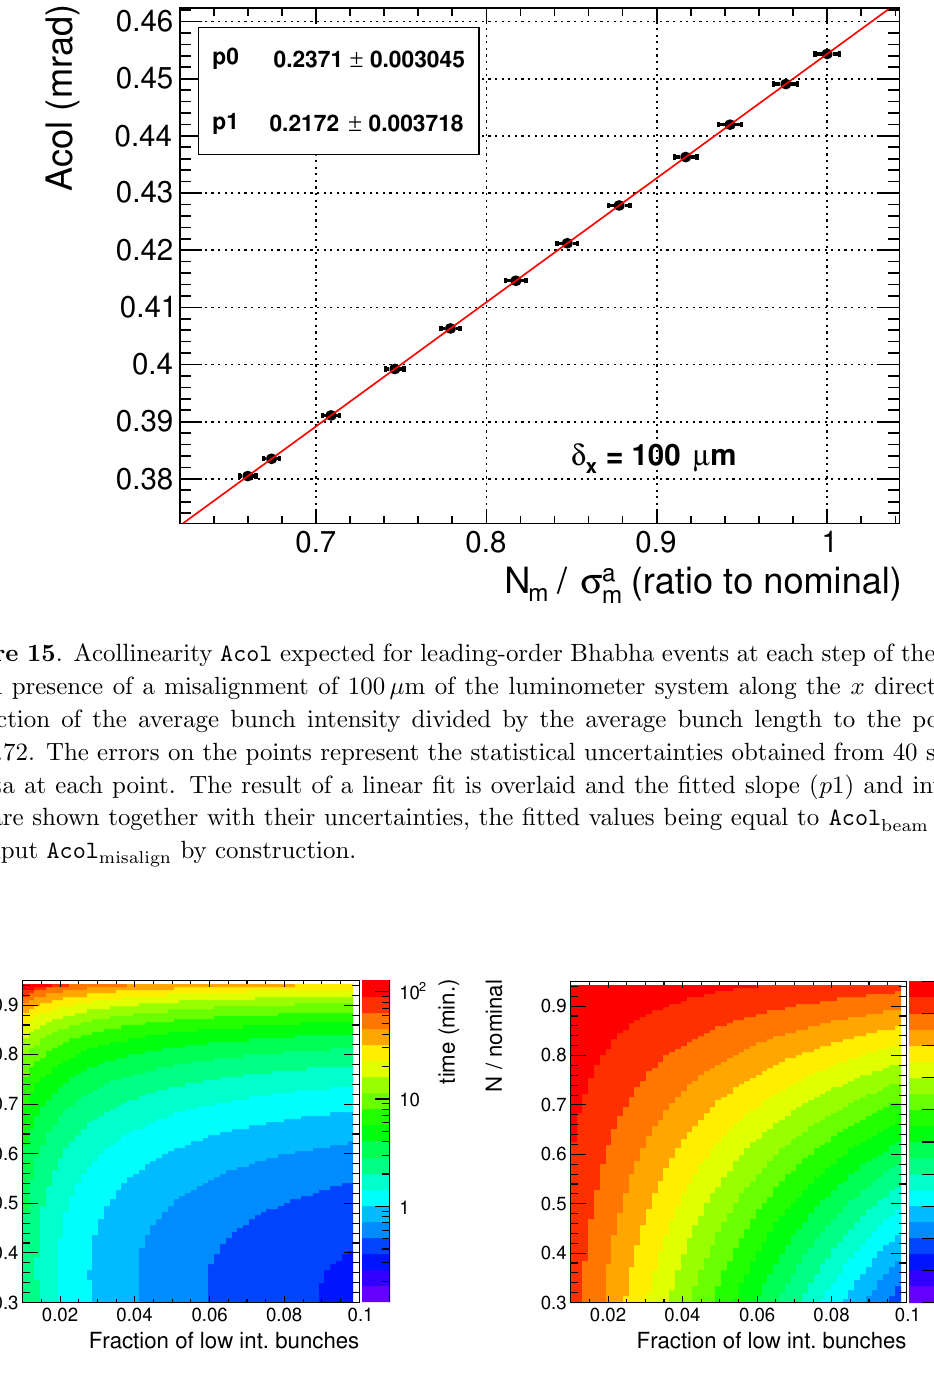
Figure 16 . Left: Time needed to measure Acol with a relative uncertainty of 5% in a setup beam with a given fraction (shown on the x axis) of pilot bunches with a lower than nominal intensity (shown on the y axis). The values of Acol predicted for leading-order Bhabha events have been used. Right: Fraction of the nominal luminosity that is kept in such a setup.